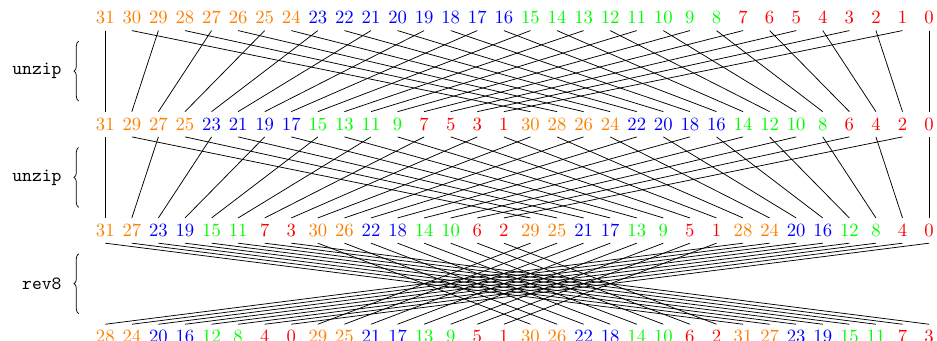
Figure 1: PermBits using instructions from Zbkb. The numbers denote the bit indices of the input 32-bit state